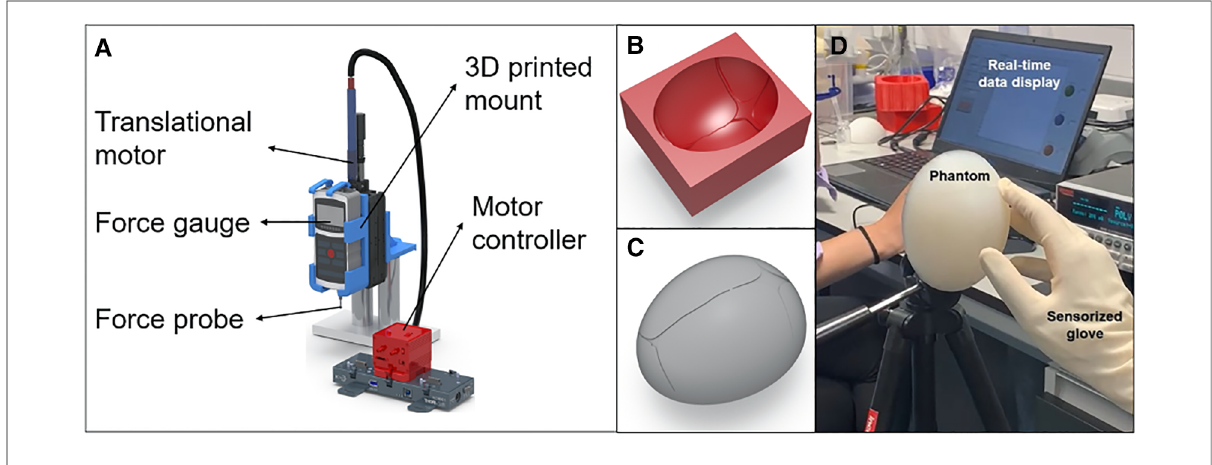
FIGURE 2 Test set up in the lab. ( A ) Schematic representation of the force calibration setup. ( B ) Mold created to fabricate phantom models of the fetal head ( C ) Schematic representation of the fetal head phantom model created. ( D ) Test set up used to validate the